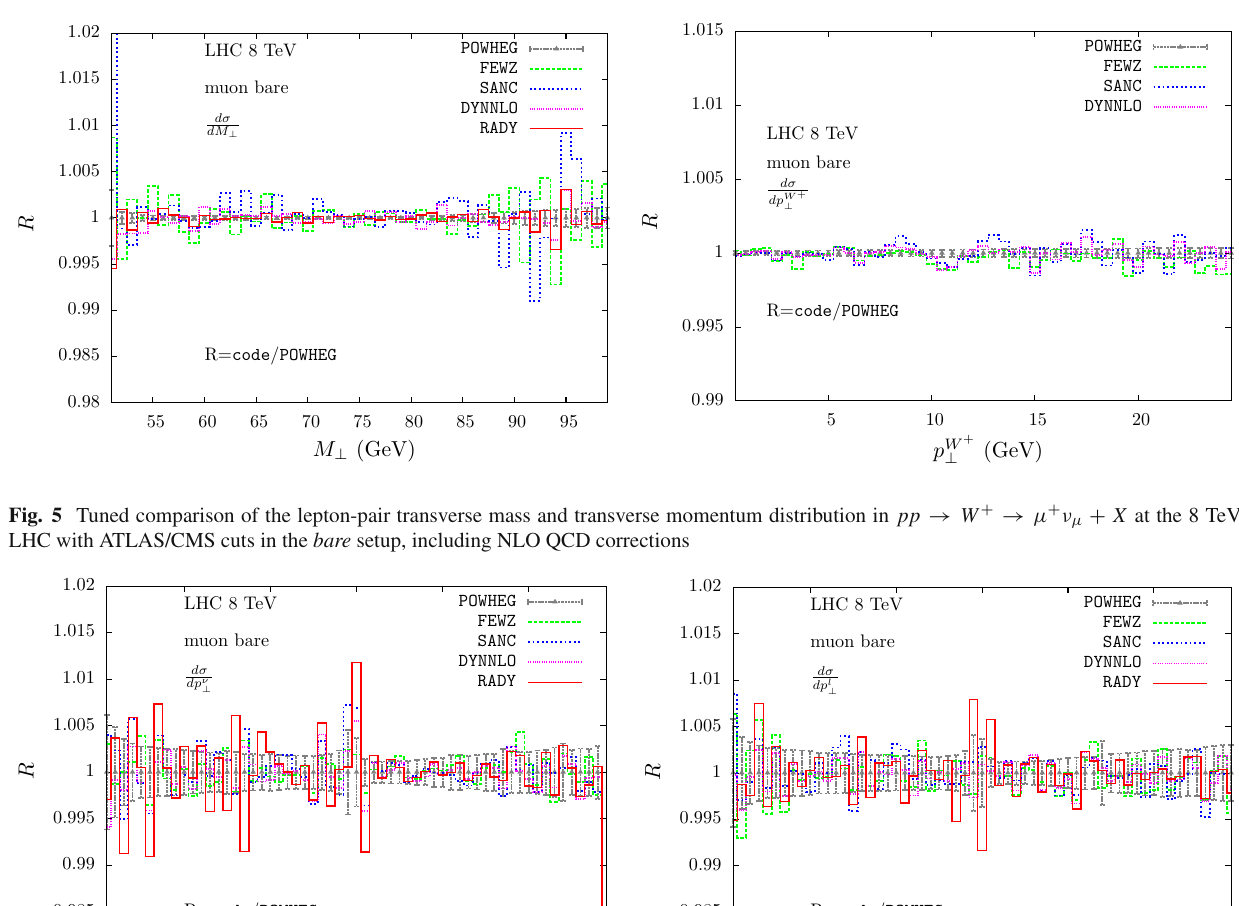
Fig. 4 Tuned comparison of the muon and muon neutrino transverse momentum distributions in pp → W − → μ − ν μ + X at the 8 TeV LHC with ATLAS/CMS cuts in the bare setup, including NLO EW corrections